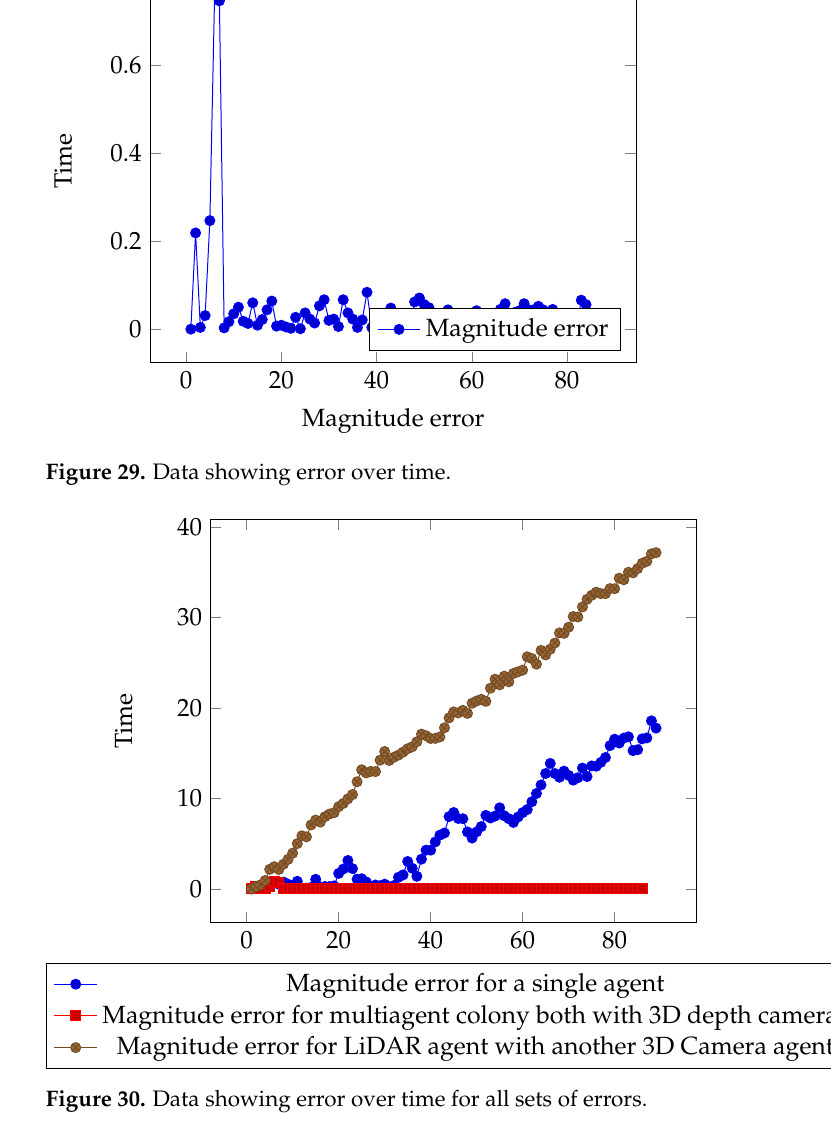
Figure 30. Data showing error over time for all sets of